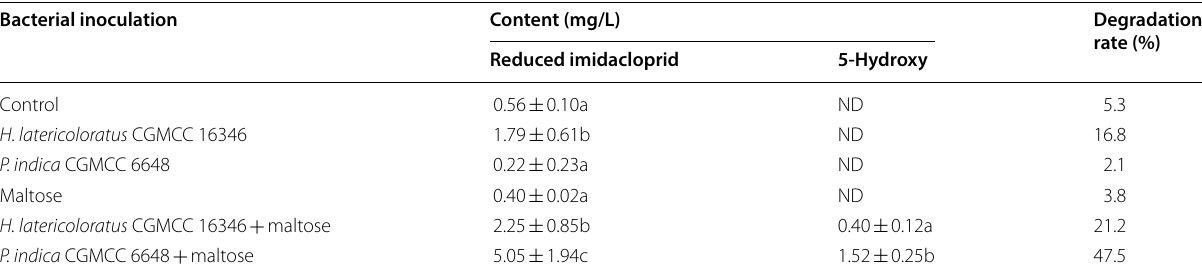
Table 2 Degradation of imidacloprid in surface water in shaking flask system